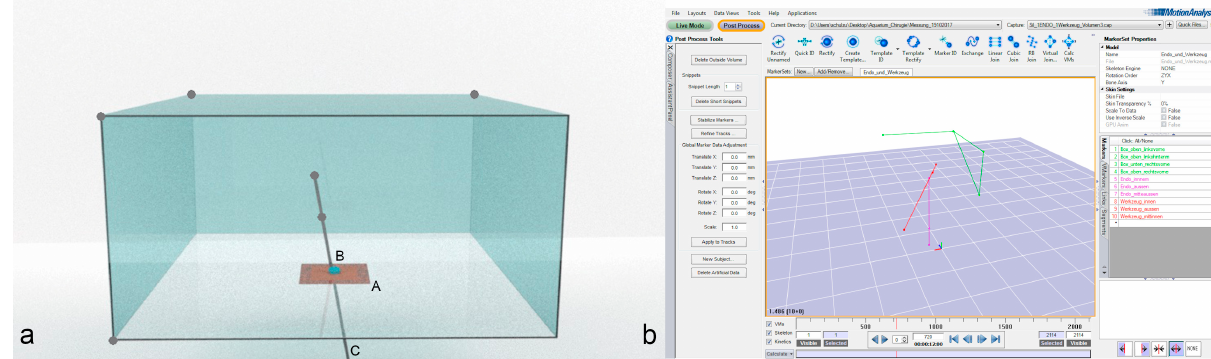
Figure 1. ( a ) Schematic drawing of the experimental setup. The artificial skin (A) holding the different ports (B) was mounted at the bottom of a clear acrylic box. A 10-mm endoscope (C) was inserted, and the maximal possible movement was recorded by 18 motion capture cameras. The positions of the reflective markers are shown as grey dots. ( b ) A picture of the recorded data recorded by the motion capture